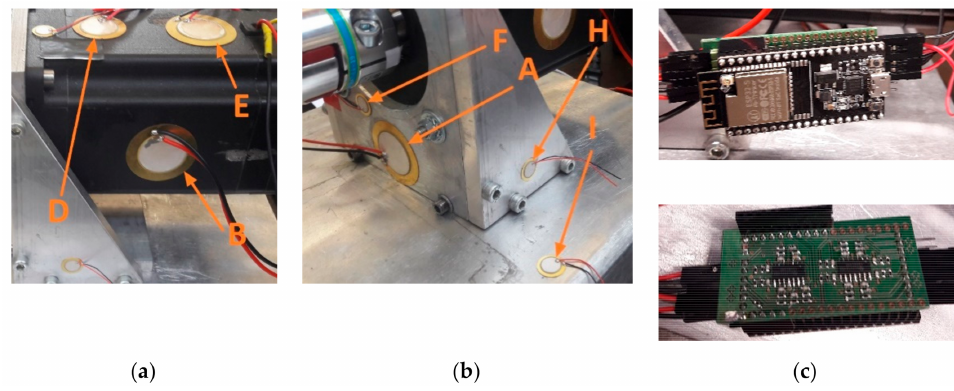
Figure 17. Piezoelectric sensors mounted on the BLDC motor and mounting base. ( a ) Left view; ( b ) Front view; ( c ) Top (ESP32 module) and bottom side (filters) of the Internet-of-Things (IoT) multi-sensory analog processing module.